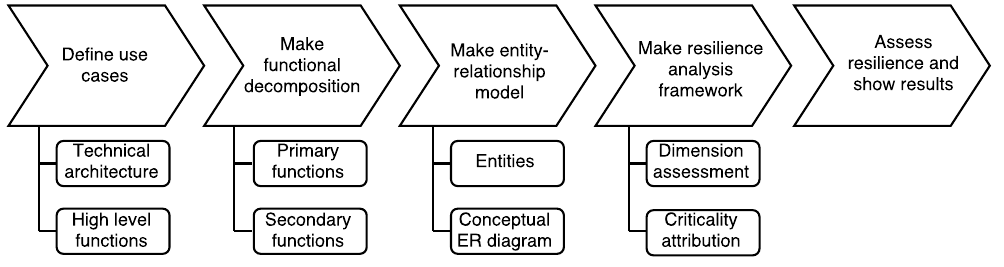
Figure 2. Workflow of the